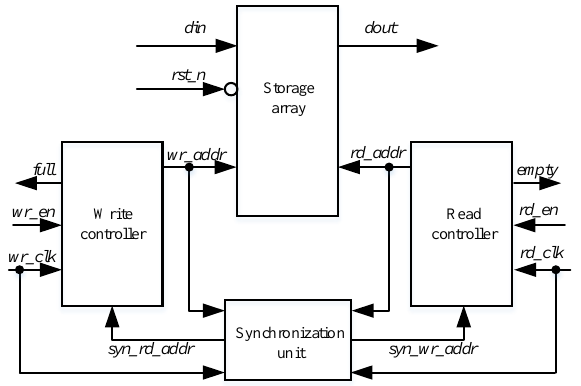
Figure 7. Asynchronous first input first utput (FIFO) circuit.